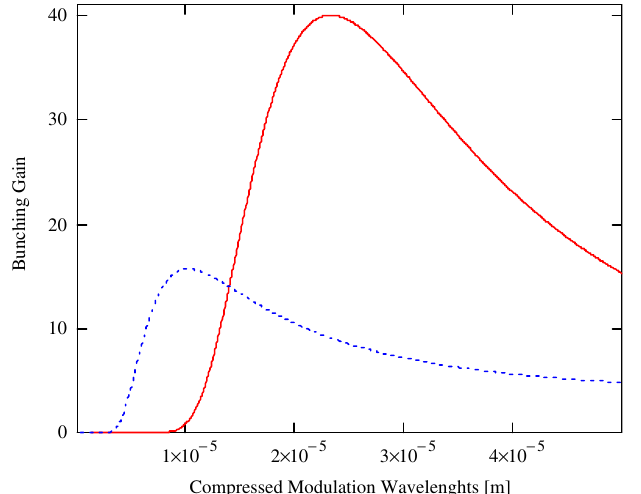
FIG. 7. Longitudinal phase space (top) and current profile (bottom) of the bunch core at the entrance of BC2. Fig. 6. The FERMI linac rf phasing was readjusted to cancel the linear chirp at BC2. Figures 7 and 8 show a portion of the bunch core at the entrance and at the exit of BC2 with R 56 ¼ (cid:2) 30 mm , respectively. At the end, the longitudinal phase space becomes folded, the energy spread is uncorrelated, for any practical purposes, on the slice scale of microns, and the charge clusters are largely suppressed. To make the dynamics more evident, initial modulation amplitude of 1% was introduced at 30 (cid:5) m wavelength, corresponding to an initial bunching factor of 7 (cid:4) 10 (cid:2) 2 . After BC2, the bunching factor calculated for 3 (cid:5) m wave- length shrinks to approximately 3 (cid:4) 10 (cid:2) 5 .